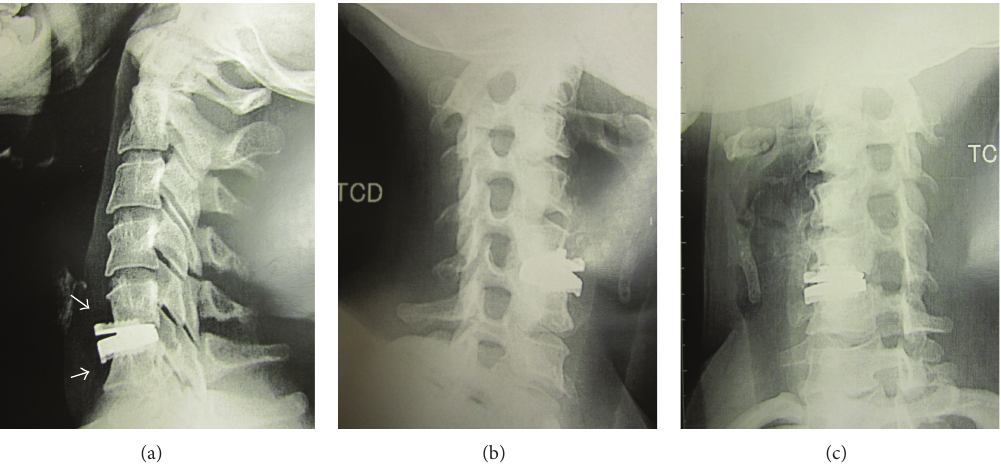
Figure 2: Plan radiographs performed after symptoms recurrence. The endplates adjacent to the prosthesis were shortened, making the prosthesis more protruding (a). The foramina were not narrowed (b and